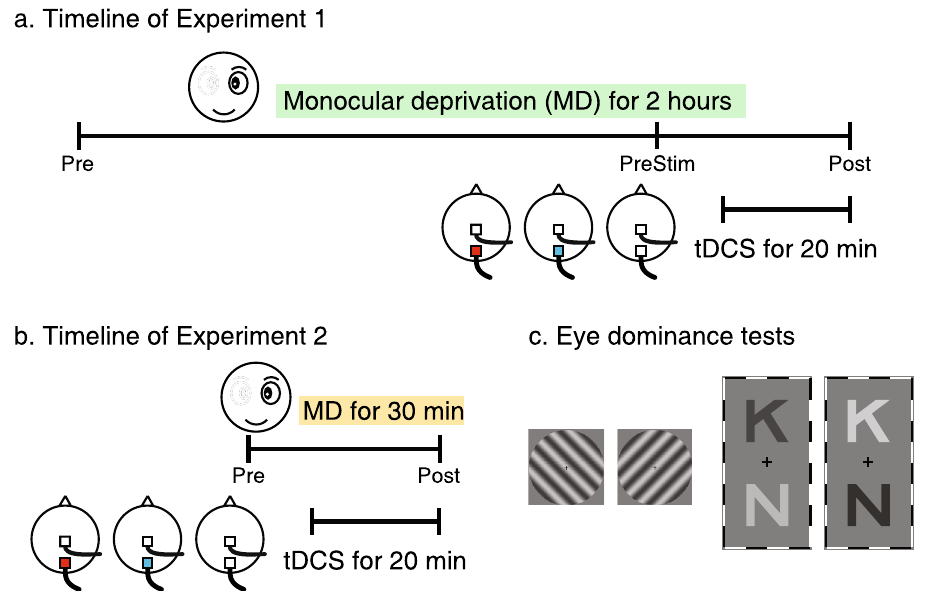
Figure 1. ( a ) Illustration of the timeline in Experiment 1. Ocular dominance was measured at baseline (Pre), before tDCS at the 90th minute of MD (PreStim) and immediately after 2 h of MD (Post). ( b ) Illustration of the timeline for Experiment 2. Ocular dominance was measured at baseline (Pre) and immediately after 30 min of MD (Post). In both experiments, a-tDCS, c-tDCS or sham stimulation was delivered to the visual cortex during the final 20 min of MD. ( c ) Examples of the two ocular dominance tests. Participants viewed the stimuli dichoptically. In the grating rivalry test, participants continuously pressed one of four buttons to indicate their perception. In the letter-polarity test, participants pressed the up or down arrow key to indicate the letter that they perceived as brighter than the